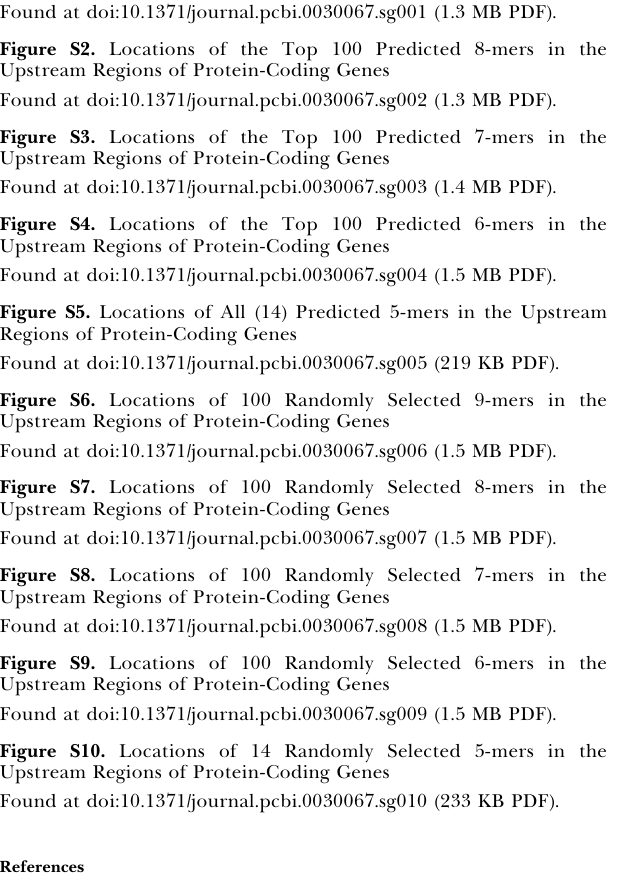
Table S1. Single Nucleotide Frequencies in the Various Datasets Table S2. miRNA Genes That Contain at Least Three Occurrences of the Motif, CGCGCG within a Contiguous Stretch of 2 kb in Their Upstream Regions ( , 10 kb) Table S3. Hexamer Motifs and TFs That Are Predicted to Regulate Specific miRNAs Table S4. A Prioritized List of TFs That Regulate